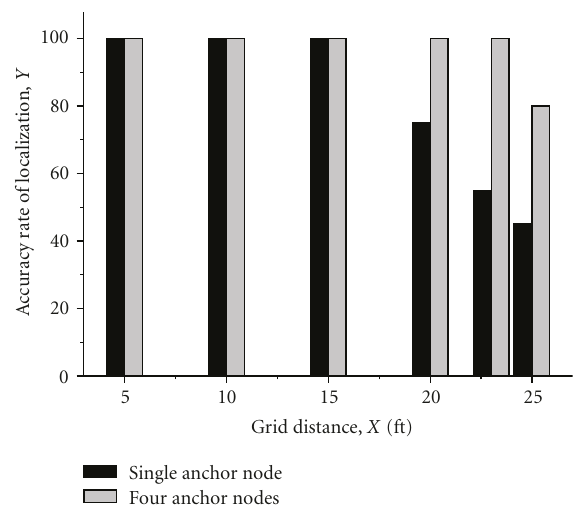
Figure 18: Localization accuracy comparison by using di ff erent anchor nodes.